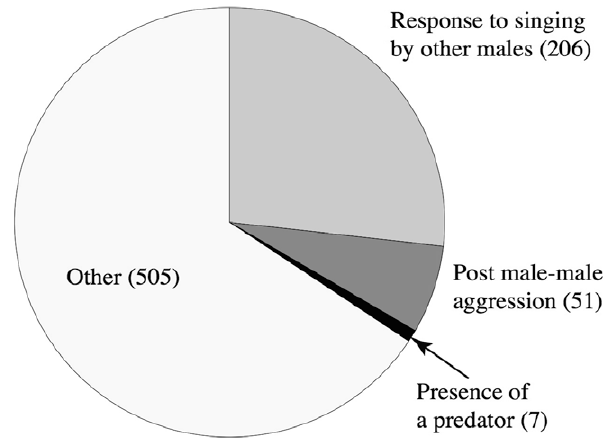
Figure 2. The distribution of events inducing male singing in natural circumstances over 11 years. No naturally recorded singing events occurred in response to pup screams.